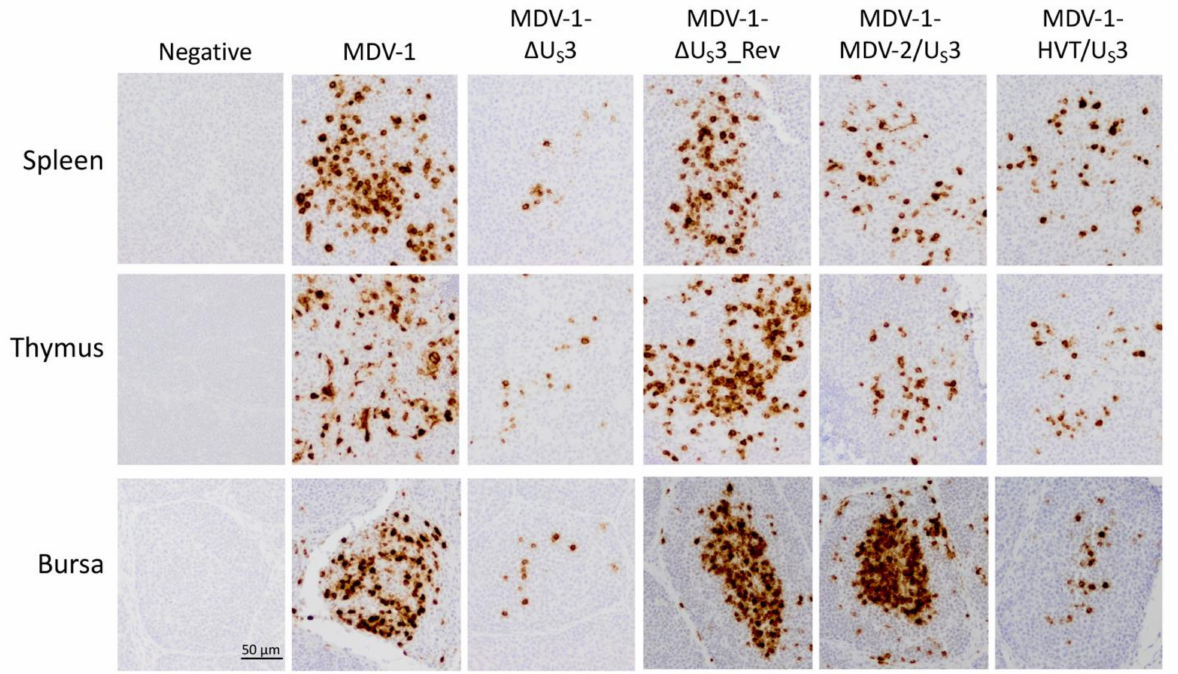
Figure 3. U S 3 of MDV-1, MDV-2, and HVT differentially regulate virus replication in lymphoid organs. At six days post- inoculation, lymphoid organs (spleen, thymus, and bursa) were collected from virus-inoculated or uninoculated (negative control) chickens, fixed in 10% neutral buffered formalin solution for 48 h, and stored in 70% ethanol until used. Tissue sections were prepared and subjected to immunostaining with anti-pp38 monoclonal antibody and VECTASTAIN ABC kit according to the manufacturer’s instructions, using DAB (3,3’-diaminobenzidine) as the substrate. A representative image of three independent samples from each group is presented; the scale bar is the same for every panel (scale bar = 50 µ